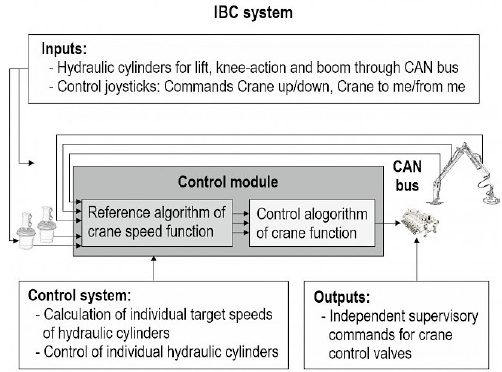
Figure 4. Principles of the IBC system [116].